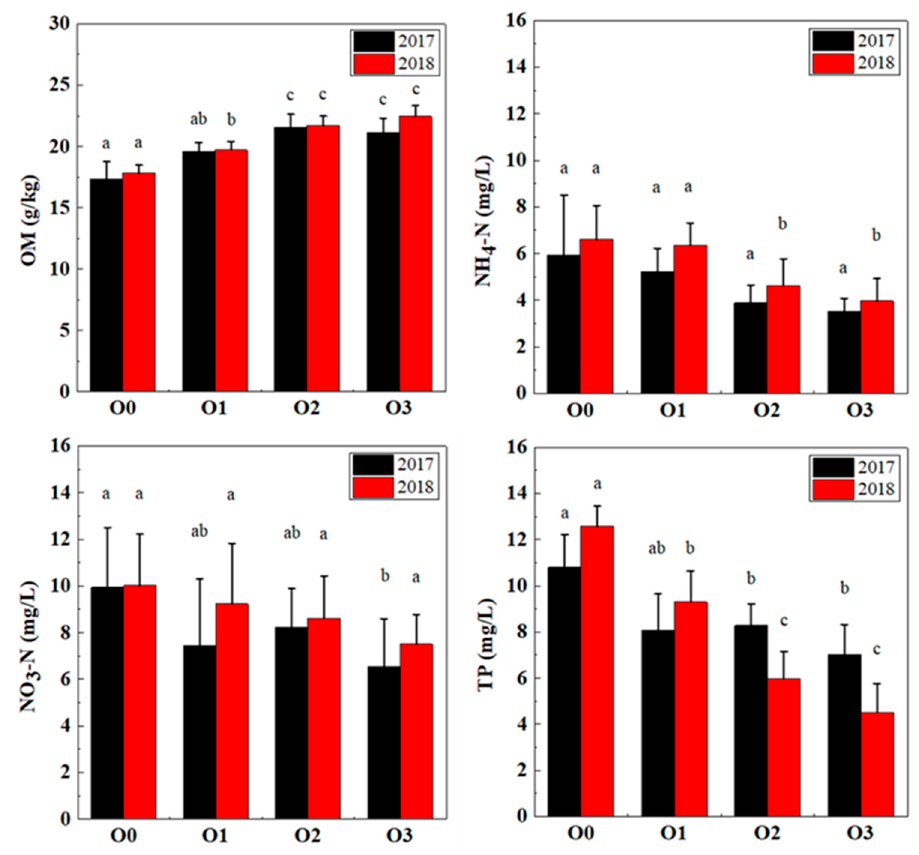
Figure 4. Tea plantation soil OM, runoff water NH 4 -N, NO 3 -N, and TP in the two-year reduction experiment. Note: values followed by different letters are significantly different ( p ≤ 0.05).